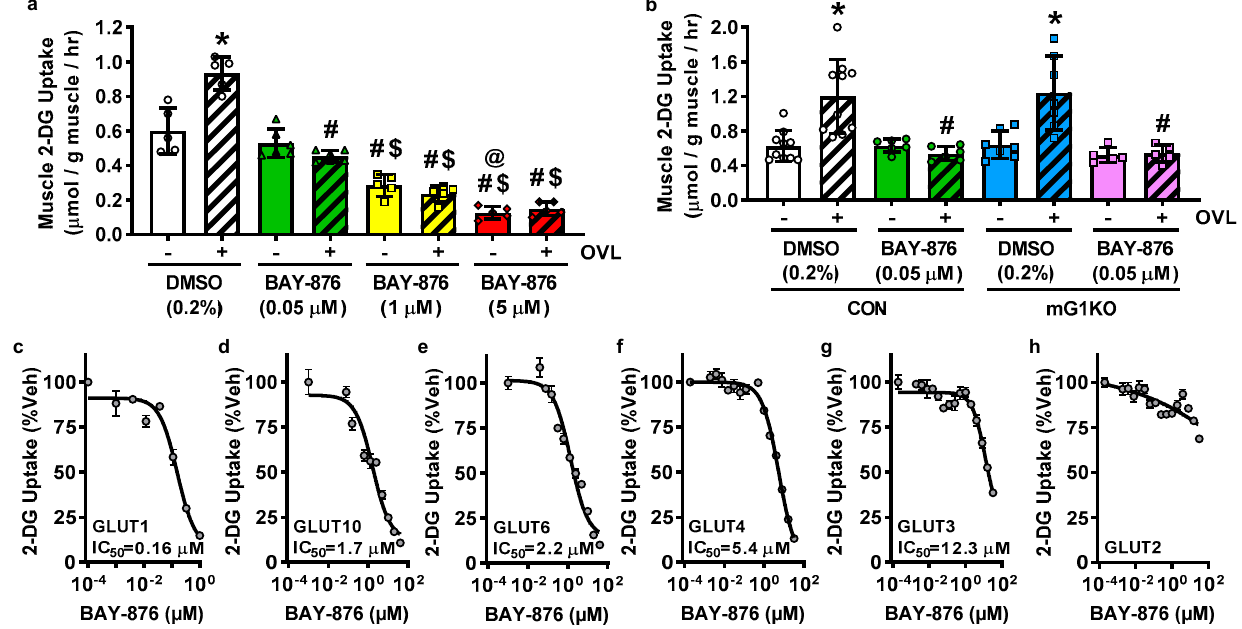
Figure 3. Effects of the chemical GLUT inhibitor, BAY-876, on glucose uptake in skeletal muscle and